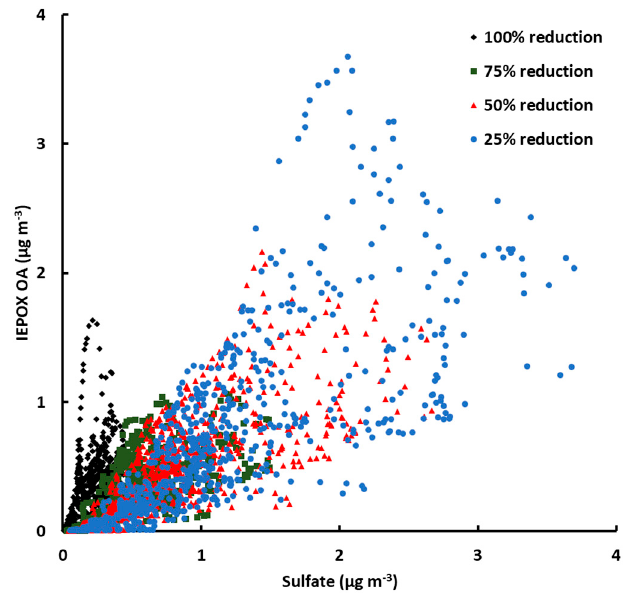
Figure 11. Correlation between sulfate and isoprene OA under 25% (blue), 50% (red), 75% (green) and 100% (black) SO 2 emission reductions.